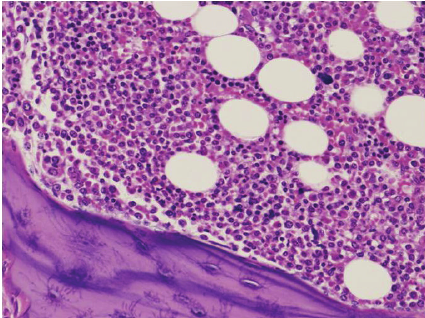
Figure 3: Hepatomegaly. The liver measured 27 × 22 × 9 cm in size and 2880 g in weight.